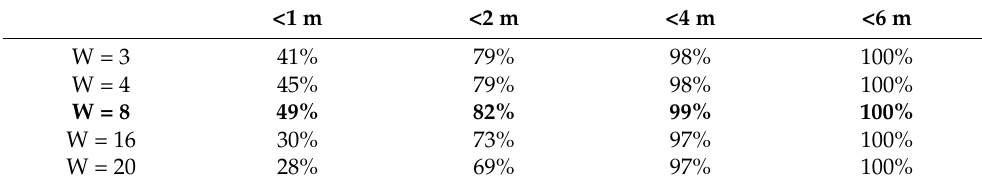
Figure 12. Cumulative distribution functions for different sequence lengths. Table 5. The proportion of the average error distance for different time-series lengths.